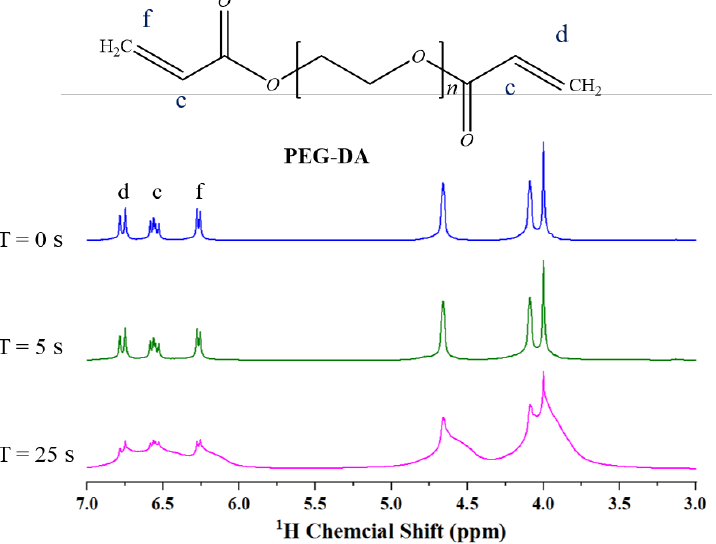
Figure 3. 1 H NMR spectrum of PEG-DA. c, d, f is the location of the hydrogen bond on PEGDA.